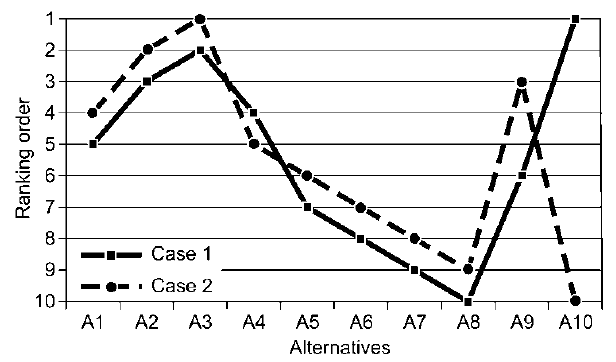
Figure 7. Ranking of alternatives for the two